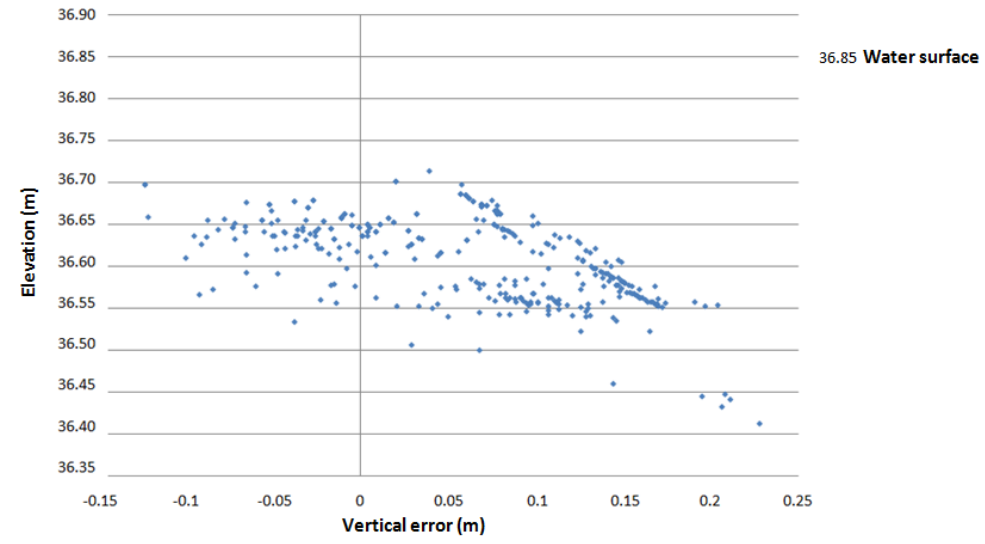
Figure 6. Vertical errors of MLS bathymetry points. ADCP measurements were used to provide reference data. The elevation of the water surface was detected with ADCP to be around 36.85 m. There are no ADCP points for the first 18 cm of